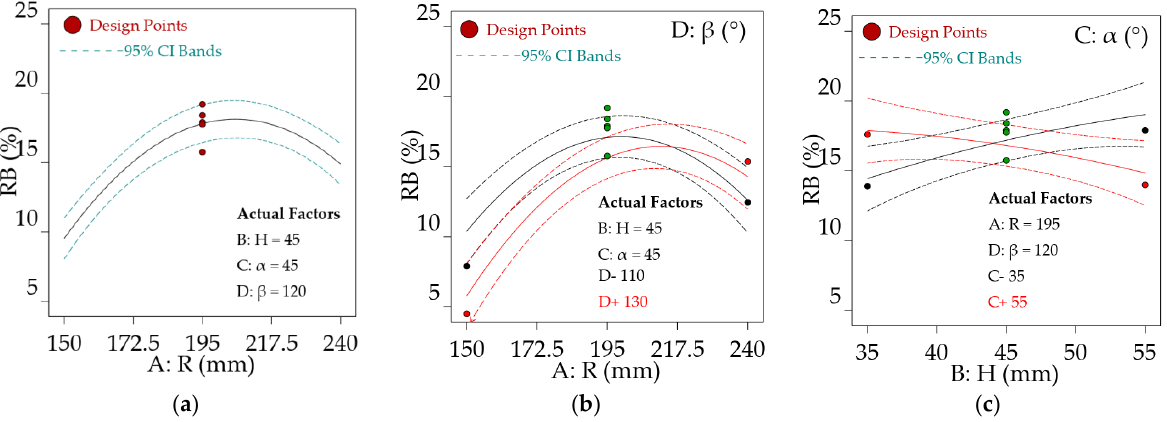
Figure 12. Rate of straw burial value at different factors.